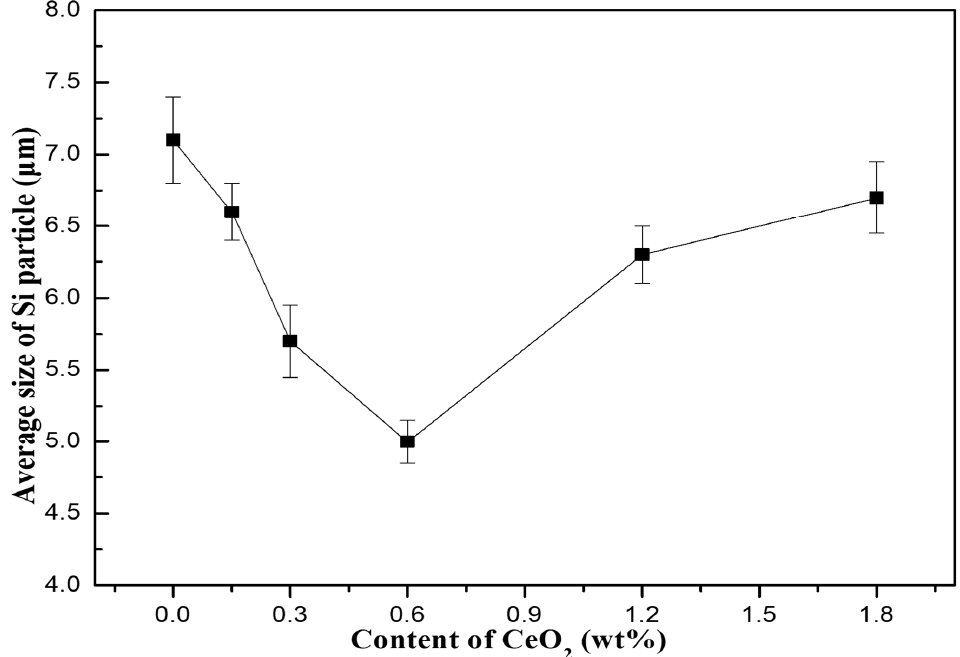
Figure 3. Average size of Si particles precipitated from SiCp/Al-Si composites with different contents of CeO 2 .